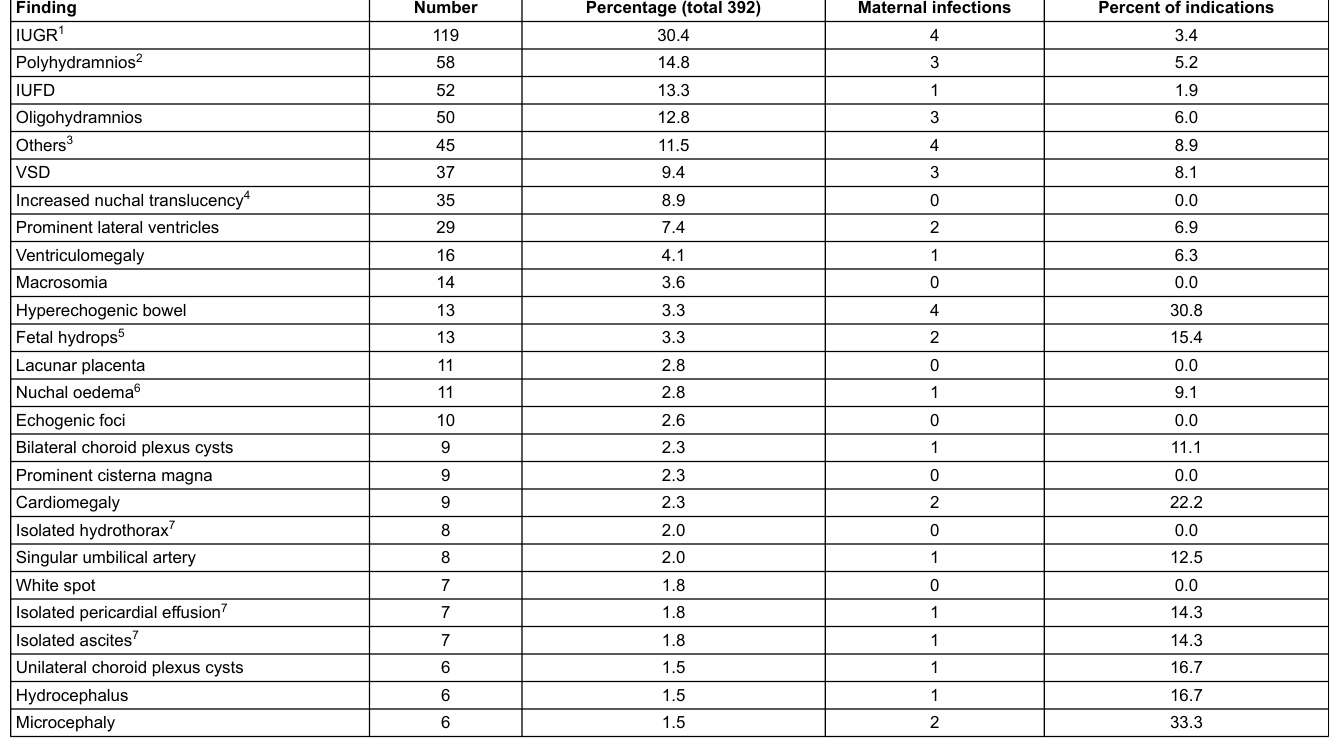
Table 1: Ultrasound indications for maternal STORCH